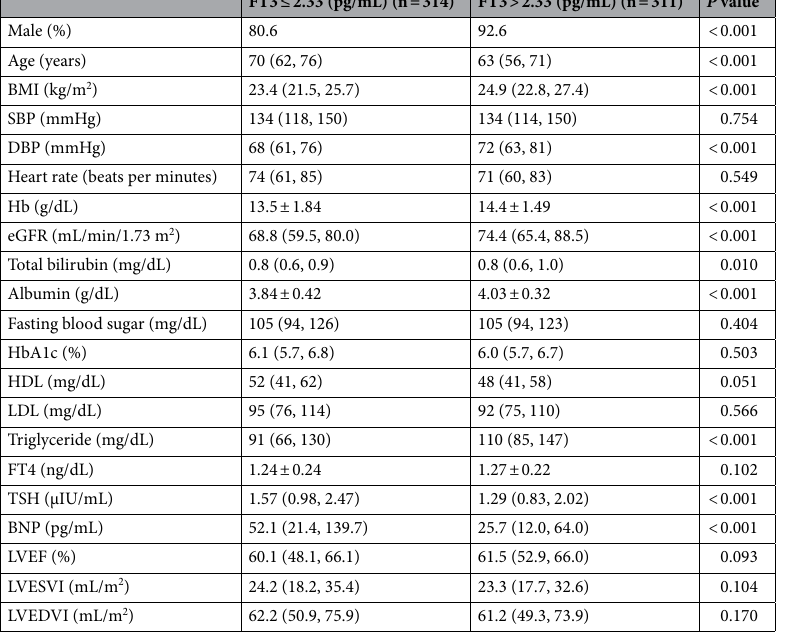
Hb, hemoglobin; eGFR, estimated glomerular filtration rate; HDL, high-density lipoprotein cholesterol; LDL, low-density lipoprotein cholesterol; FT4, free thyroxine; TSH, thyroid-stimulating hormone; LVEF, left ventricular ejection fraction; LVESVI, left ventricular end-systolic volume index; LVEDVI, left ventricular end- diastolic volume index.